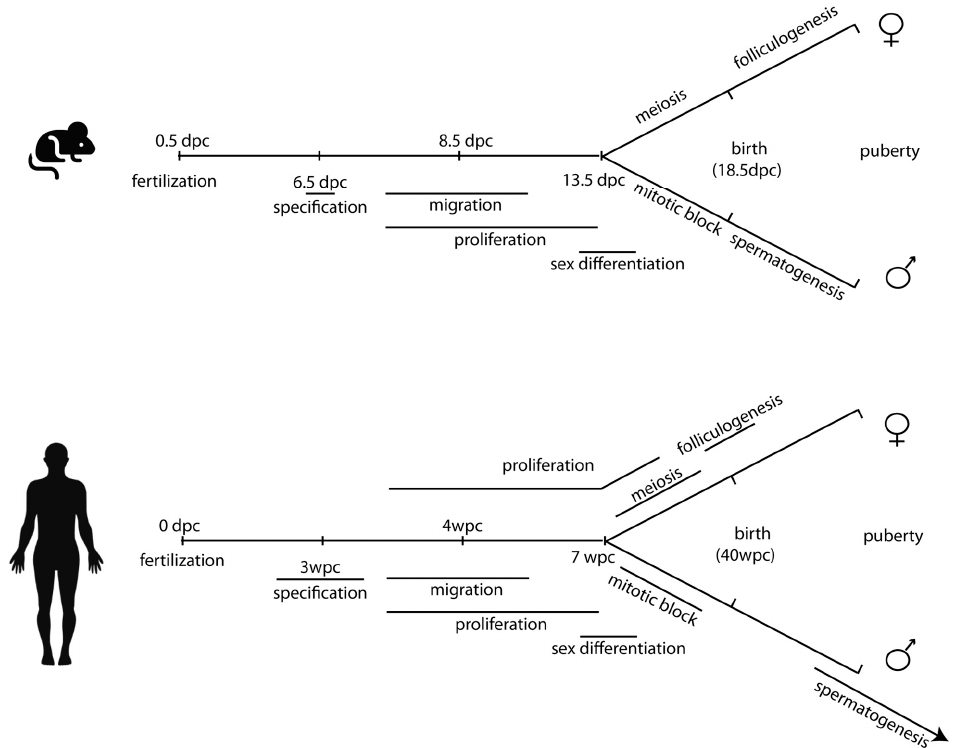
Figure 1. Parallel timetable of germ cell development in mice and humans.